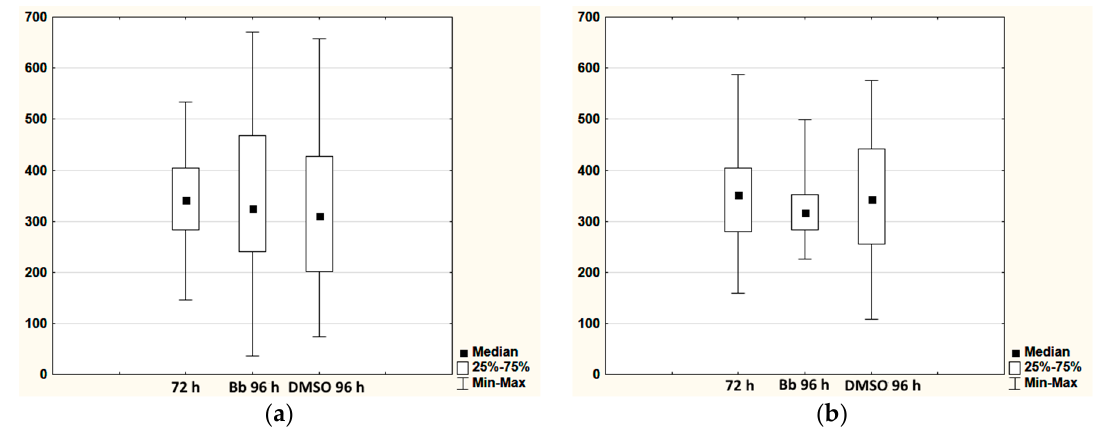
Figure 2. Comparative diagrams for the loaded hydrogels cryostored for ( a ) 6 months, ( b ) 9